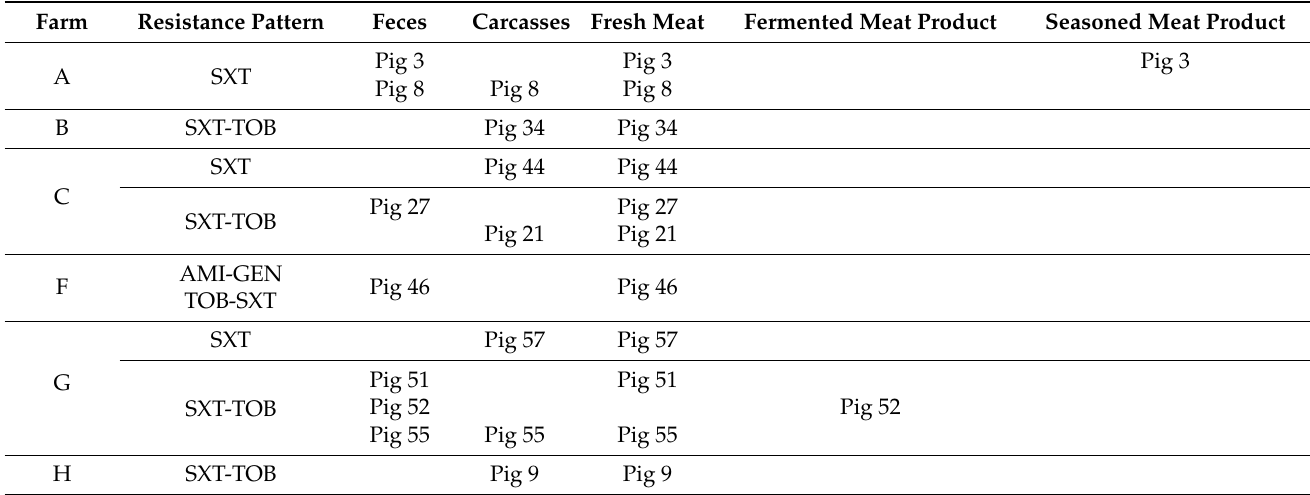
Table 1. E. coli AMR pattern isolated in the entire food chain (feces, carcasses, and pork meat products of the same pig). The enumeration of “Pig” is independent and related to each farm.